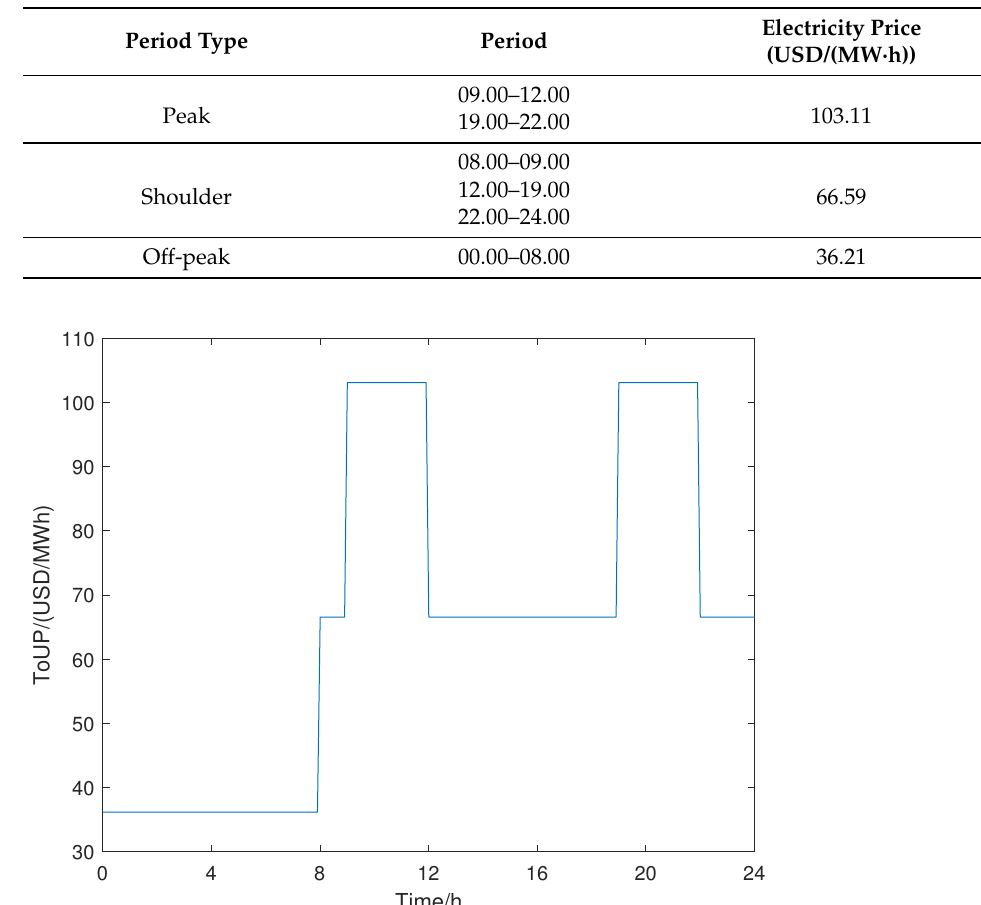
Figure 4. ToUP during a